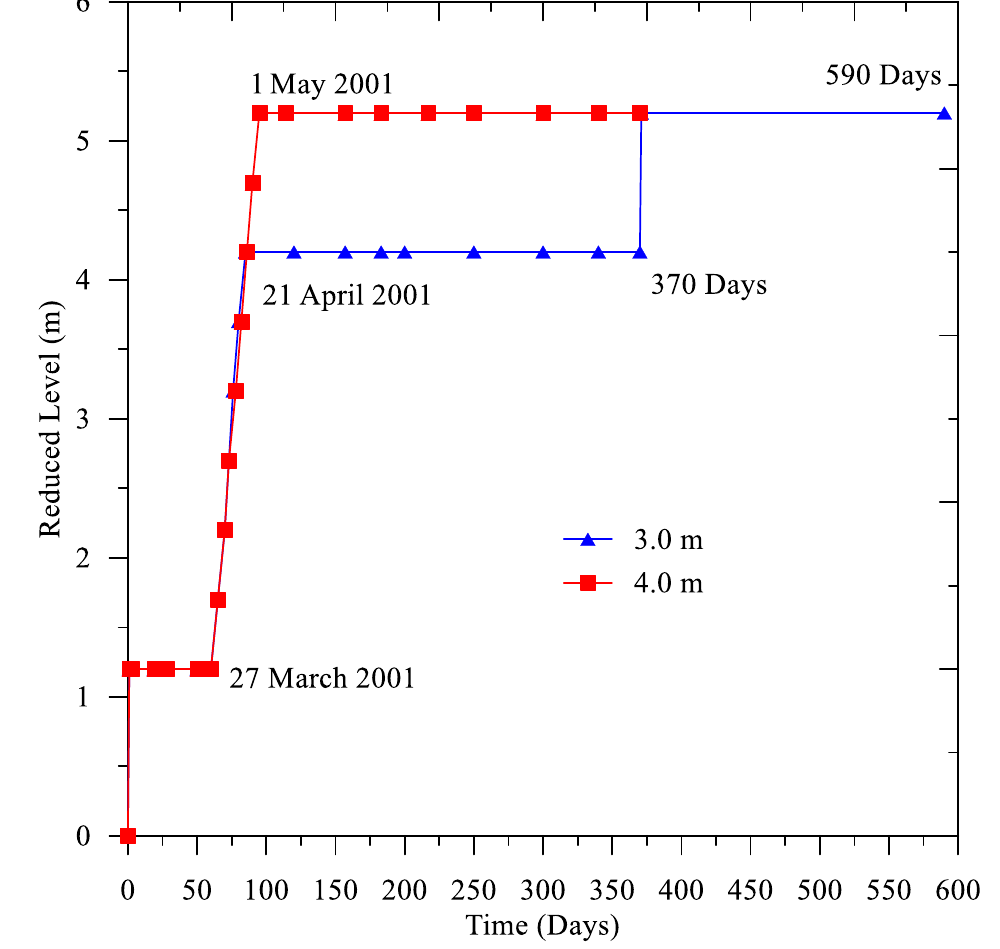
Figure 21. Construction history of the Nerang Broadbeach Roadway embankment sections.